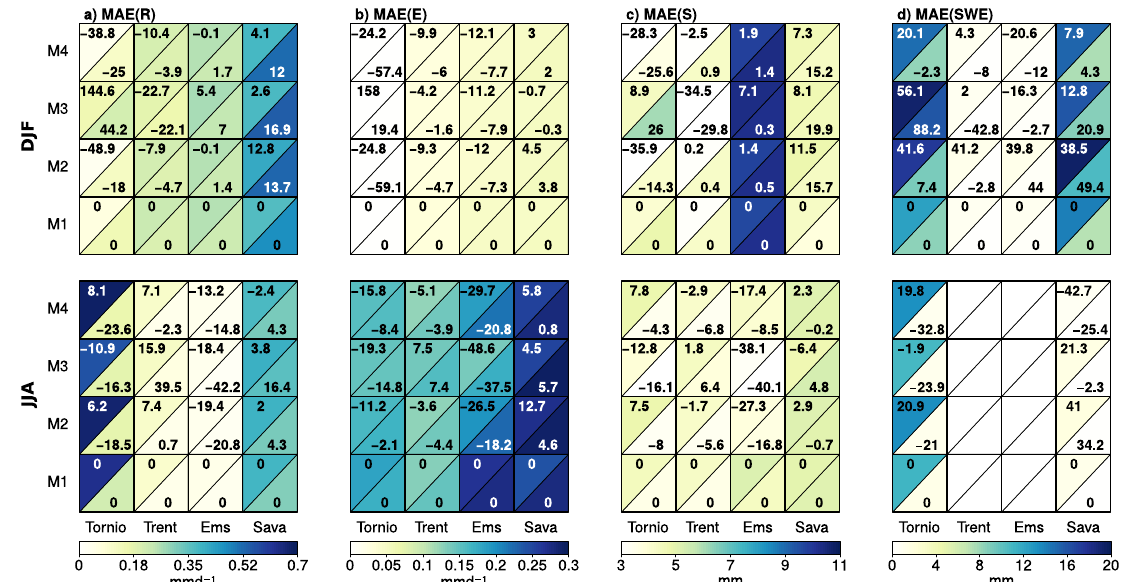
Figure 9. As in Figure 8 but shown for monthly mean ( a ) total runoff, ( b ) evapotranspiration, ( c ) soil moisture and ( d ) snow water